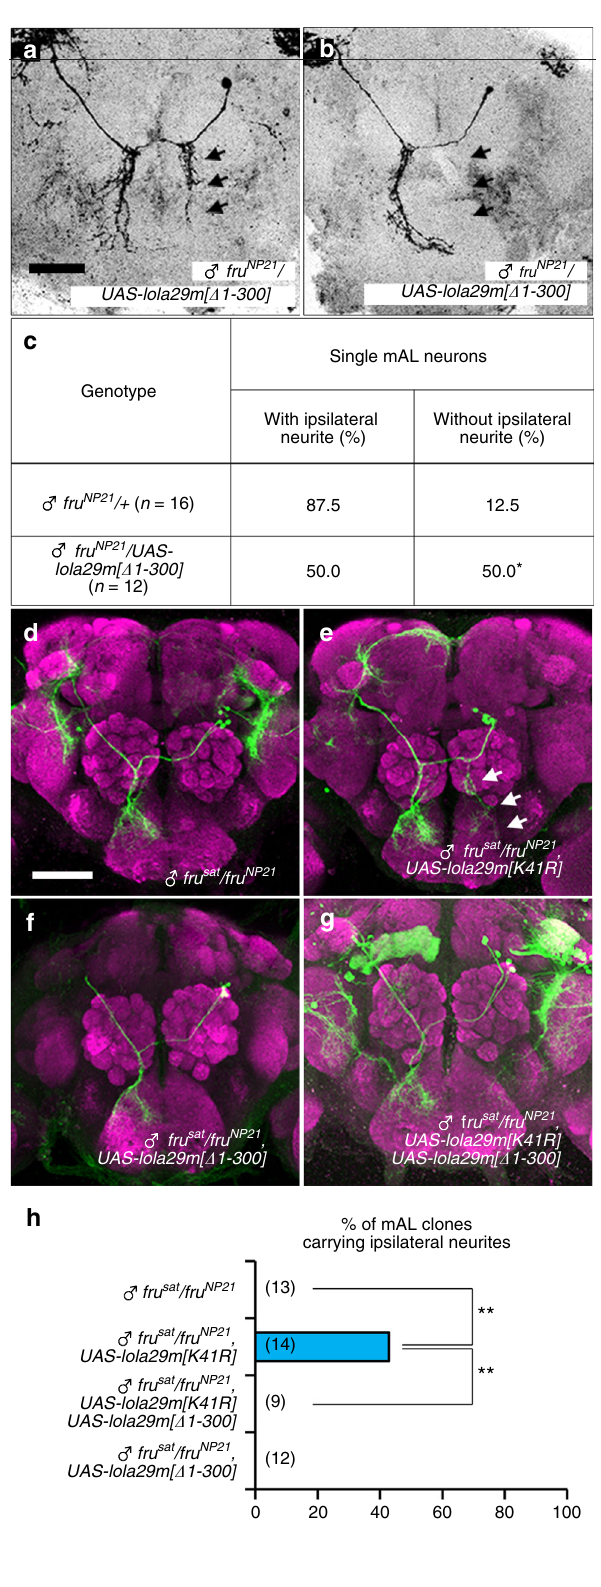
Fig. 3 Lola29M promotes whereas Lola29F impedes male-typical neuritogenesis. a – c Analysis of single-cell mAL clones overexpressing Lola29F-like. Examples of single-cell clones ( a , b ) and the proportion of fl ies that carry single-cell mAL clones with or without the ipsilateral neurite ( c ). Scale bar: 50 µ m. Statistical differences were evaluated by the Fisher ’ s exact probability test (* P < 0.05). d – h mAL neurons in fru mutant (FruM protein-null) males without ( d ) or with overexpression of truncation- resistant Lola29M[K41R] ( e ) or Lola29F-like ( f ), or both ( g ). Representative MARCM clones are shown. h Quantitative comparisons of the percentage of mAL neuroblast clones that carried ipsilateral